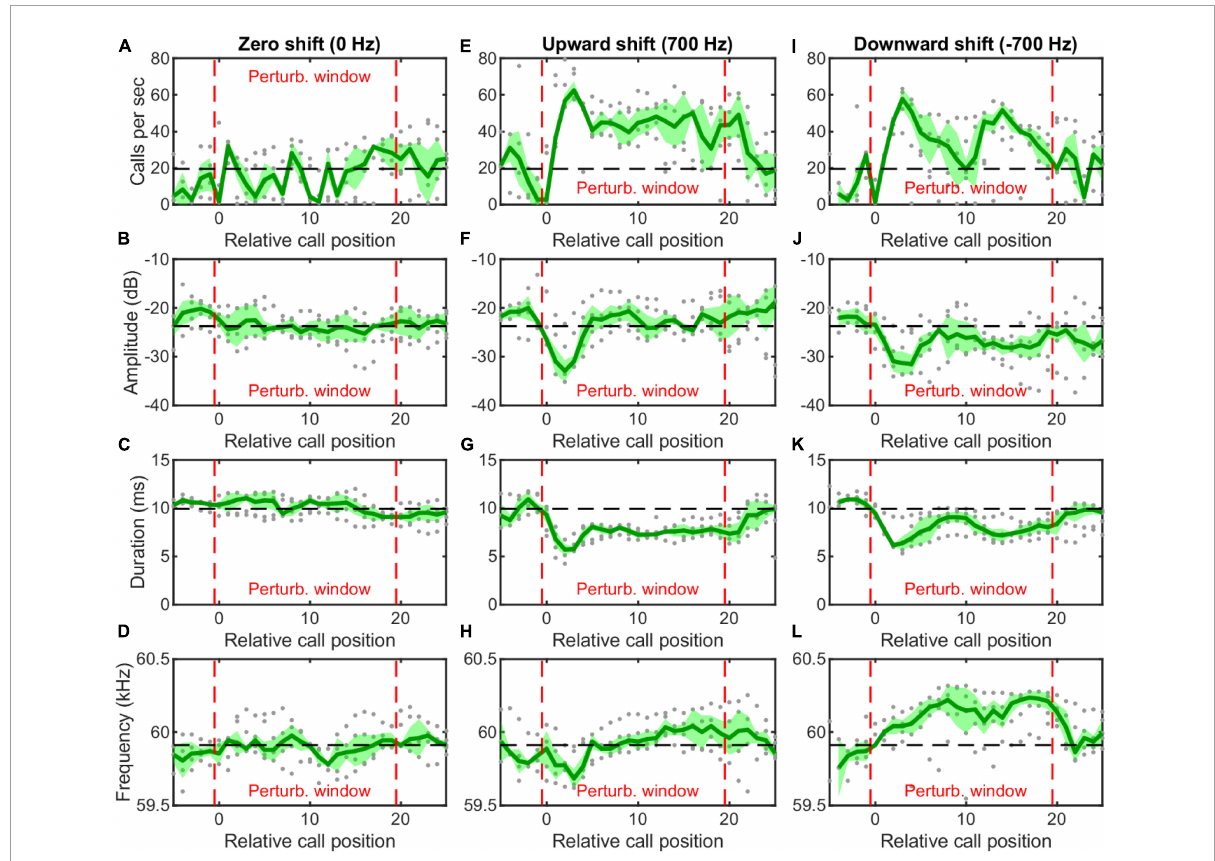
FIGURE4 Vocal behavior of a hanging Hipposideros pratti in response to online frequency-shifted auditory feedback. For each trial, the bat received 20 consecutive frequency-shifted auditory feedback during the perturbation window (between the red dashed lines). The bat did not make any vocal adjustment when received 0-Hz shifted auditory feedback (A–D) , but increased call rate (E,I) , decreased call amplitude (F,J) and call duration (G,K) , and decreased (H) or increased (L) call frequency when received upward shifted and downward shifted auditory feedback for at least a few vocalizations. The gray dots show the individual trial data; the green line and the shaded green area show the average and standard deviation for all the trials (five trials per condition and